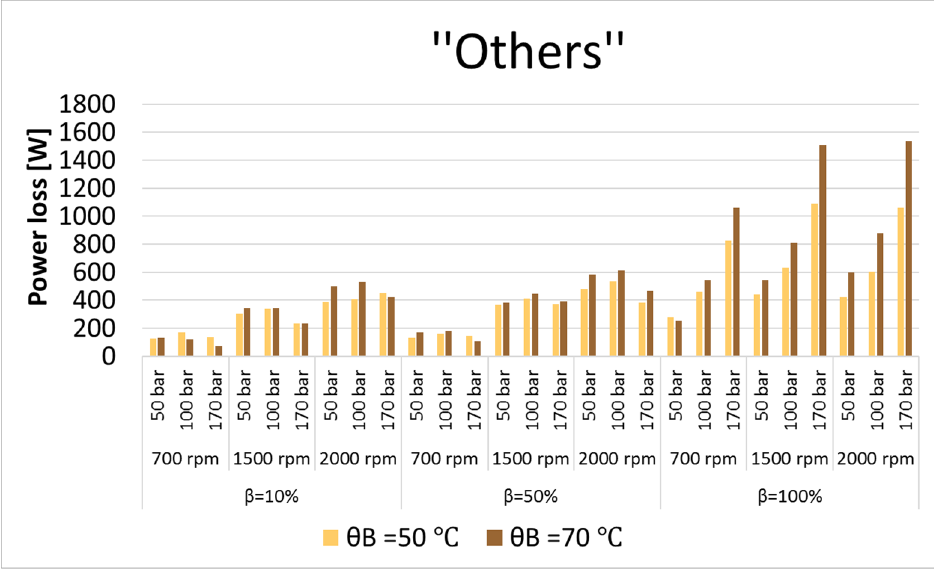
Figure 31. Undefined losses at different operating conditions.